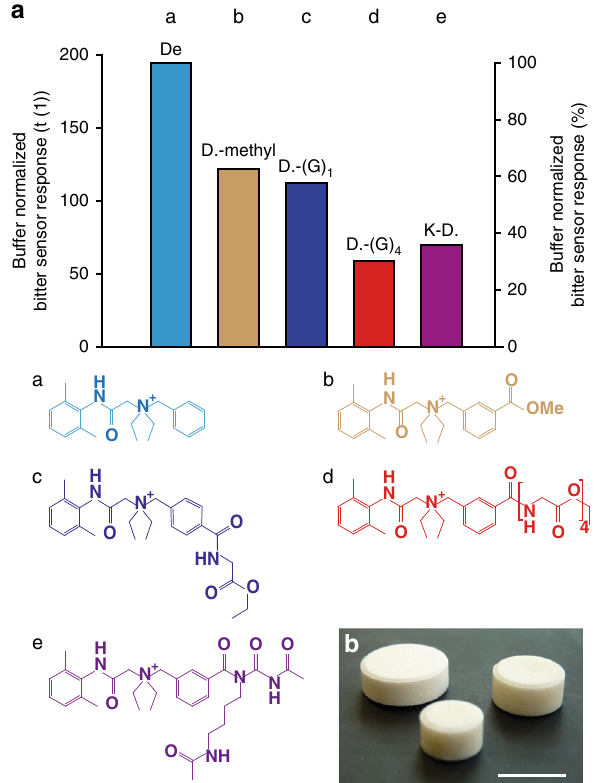
Fig. 5 Potentiometric analysis of bitterness in Euclidian distances [t(1)] (see Supplementary Fig. 12 for details). a Bitterness response of denatonium (De; structure a), structure b (D-methyl), structure c (D-(G) 1 ), structure d (D-(G) 4 ), and structure e (K-D). Values were normalized to plain buffer responses. All experiments were performed with n = 3. b Prototype of the compressed chewing gums. Scale bar length equals 1